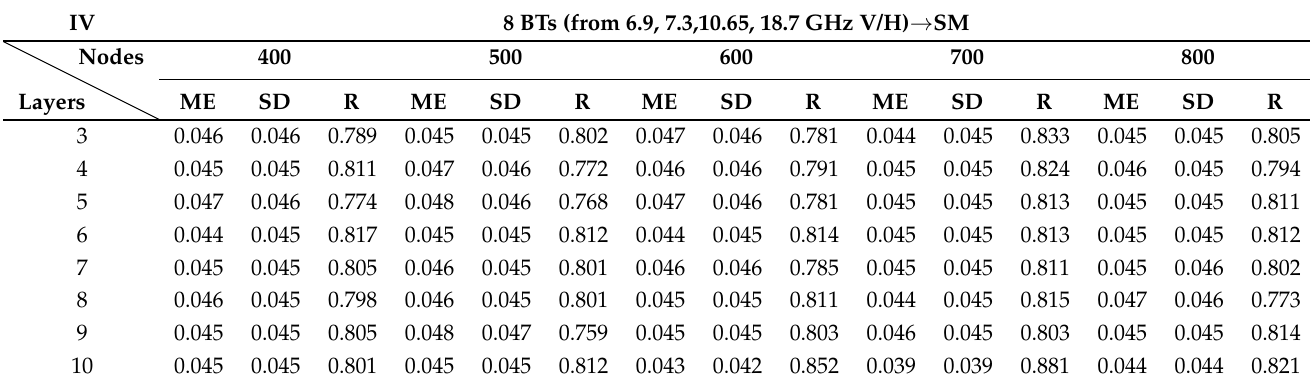
Table 4. Eight channels are used to retrieve SM (brightness temperature combination of eight